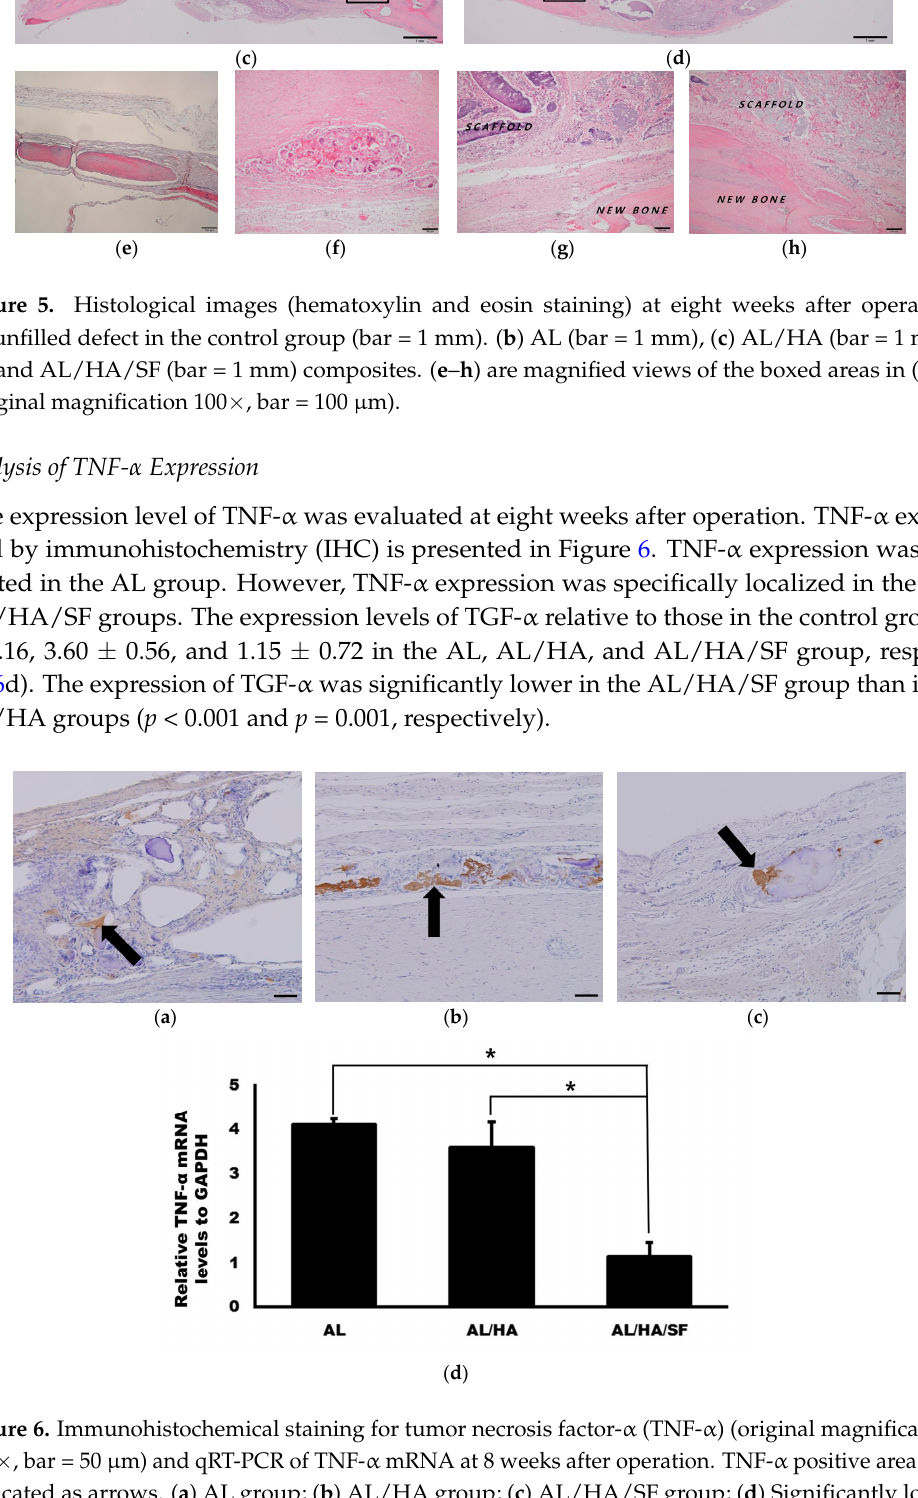
Table 1. Histomorphometric analysis.